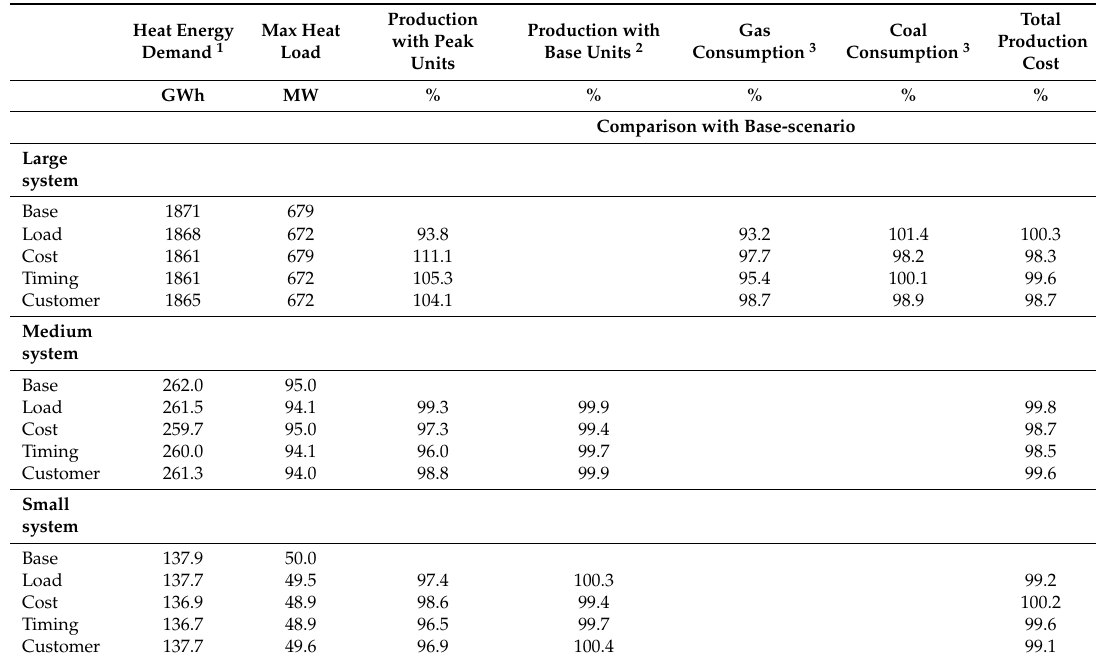
Table 2. Results of the DSM scenarios for different-sized DH